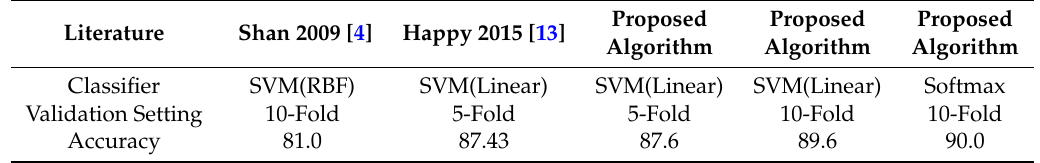
Table 7. Recognition rate on